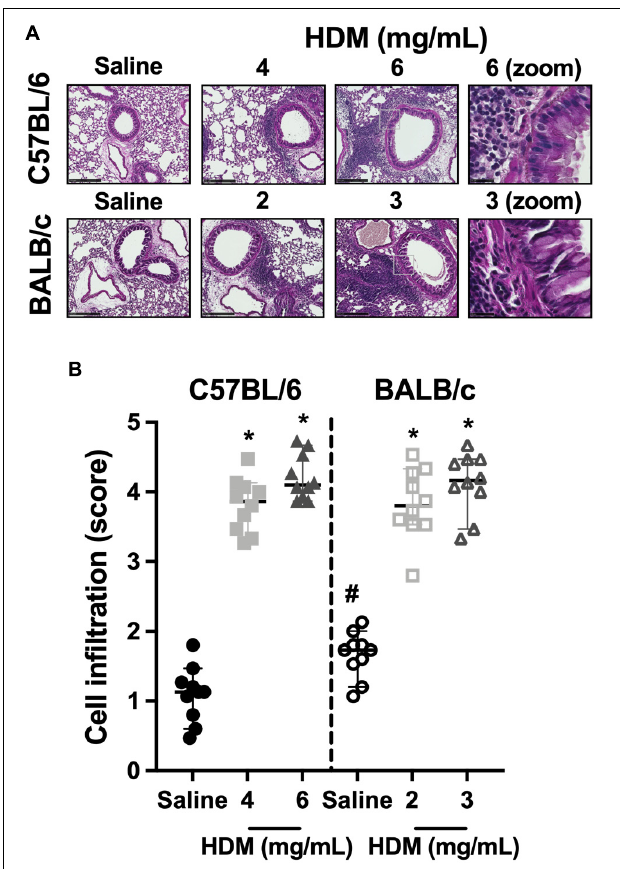
FIGURE 5 | Inflammatory cell infiltrates within the lung tissue. The images in (A) show representative lung sections from C57BL/6 (upper panels) and BALB/c (lower panels) mice exposed to incremental doses of house dust mite (HDM) (from left to right). The zone enclosed by the gray square on images of the third row is zoomed on the next image on the right. The scale bar is 250 µ m for the six first images from the left and 25 µ m for the last two images on the right. An inflammatory score was assigned to each of these images and average results for each mouse in all groups are presented in the scatter plot shown in (B) . * and # designate significantly different from saline-treated mice within the same mouse strain and from the other mouse strain exposed to the same treatment, respectively ( P < 0.05). Data are shown as medians with 95% confidence intervals. n = 10 mice per group.